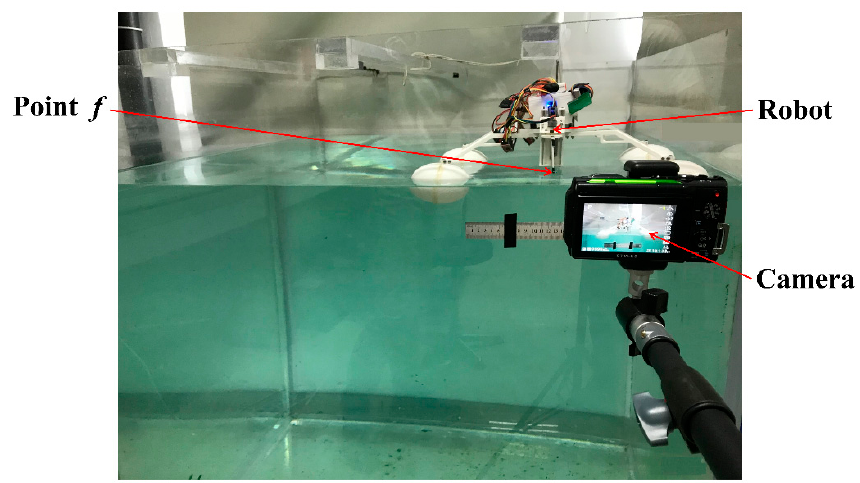
Figure 16. The experimental record of the stroke mechanism sliding on the water from the viewpoint of one side.